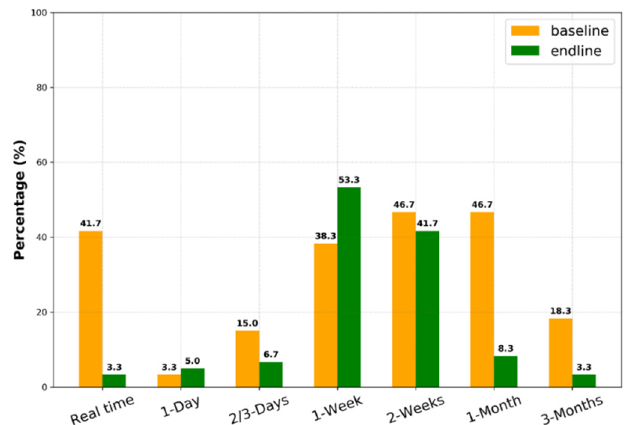
Figure 6. Baseline versus endline lead-time of hydroclimatic information needs of smallholder farmers in periurban areas of the Lower Bengal Delta.